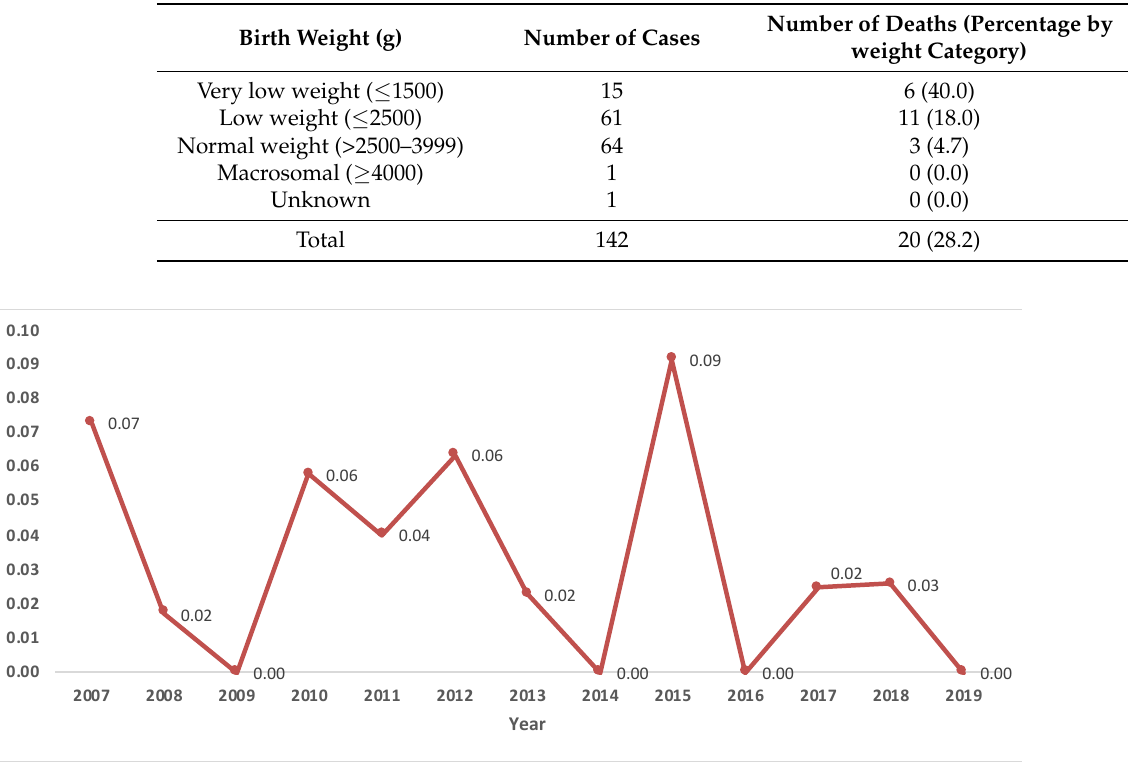
Figure 3. Evolution of the annual mortality rate (per 1000 births) in live-birth cases with oesophageal atresia during the period 2007 – 2019 in the Valencian Region.